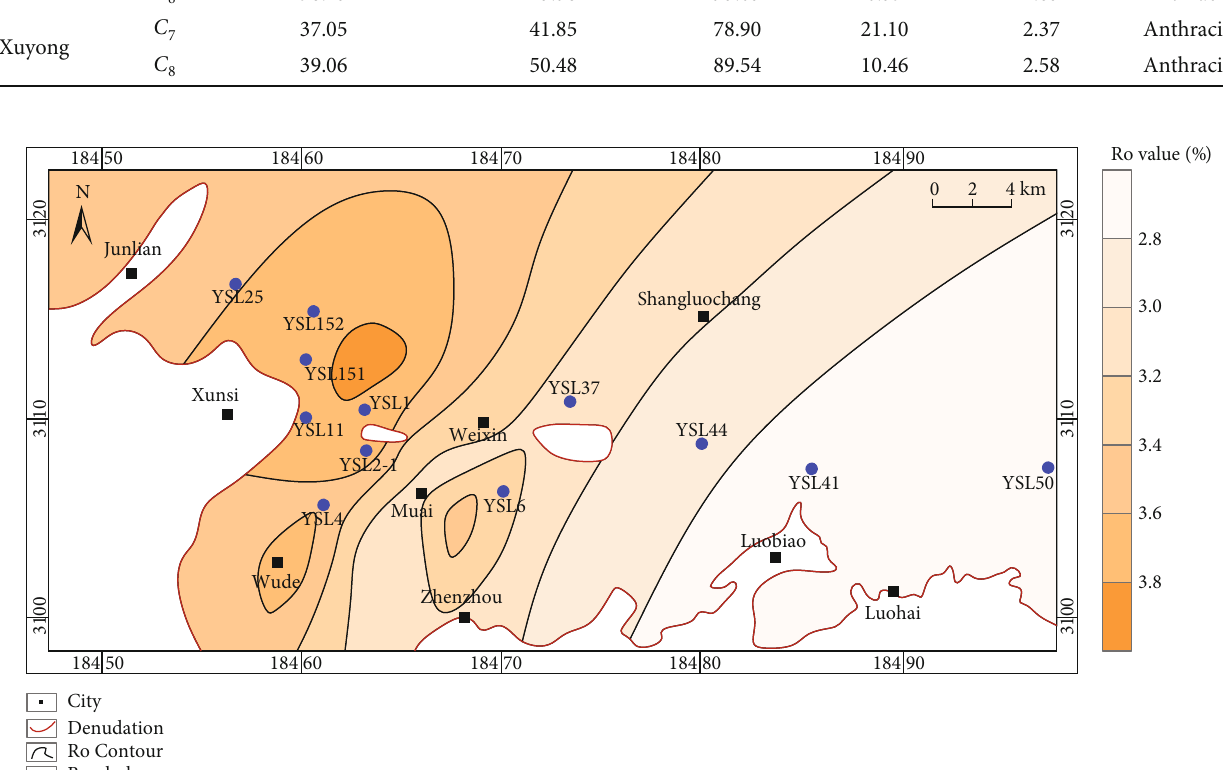
C + C 7 8 coal seam in Junlian mining